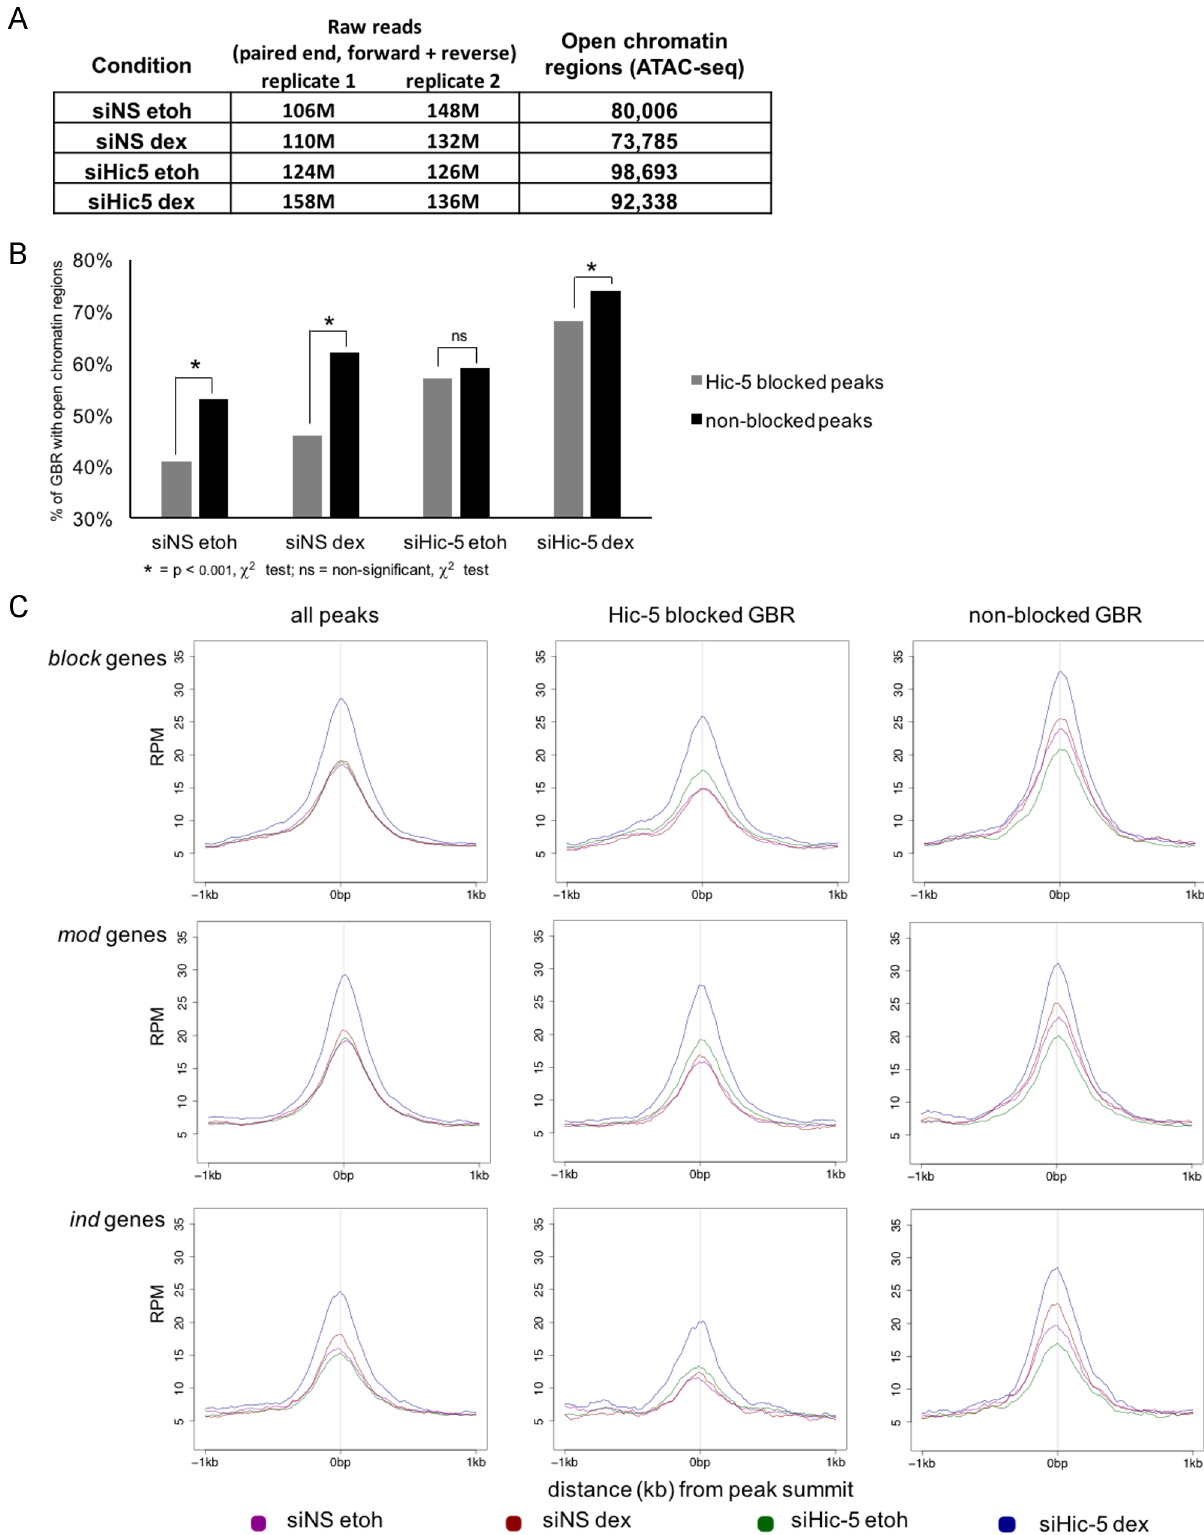
Fig 4. Chromatin at Hic-5 blocked GBR is less accessible than at non-blocked GBR. Genome-wide ATAC-seq analysis was performed to evaluate changes in chromatin structure caused by Hic-5 depletion in cells treated with dex or vehicle ethanol (etoh). (A) Total number of open